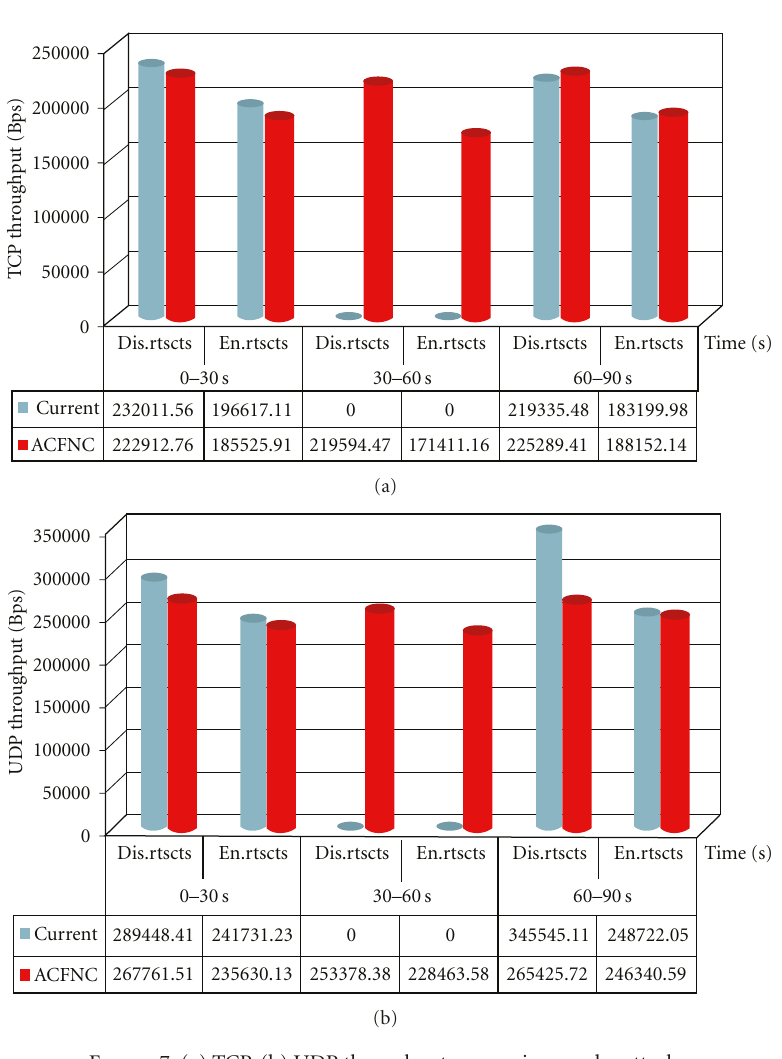
Figure 7: (a) TCP, (b) UDP throughput comparison under attacks.